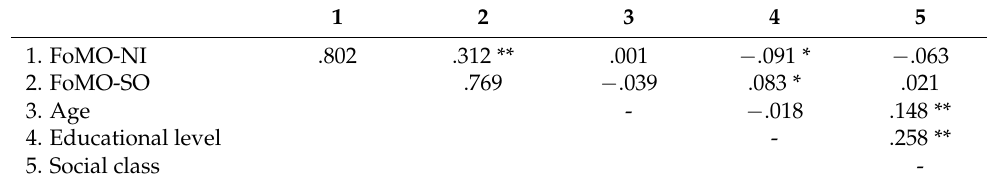
Table 2. Relationships between FoMO dimensions, age, educational level and social